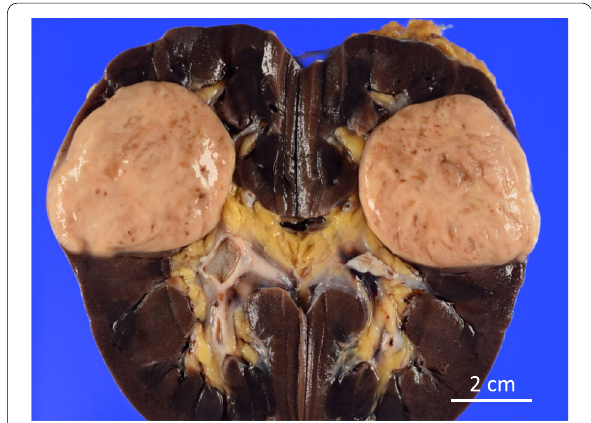
Fig. 1 Gross appearance of the tumor. The tumor was well-circumscribed, tan-white to tan-pink and homogeneous, and solid, and it showed expansile